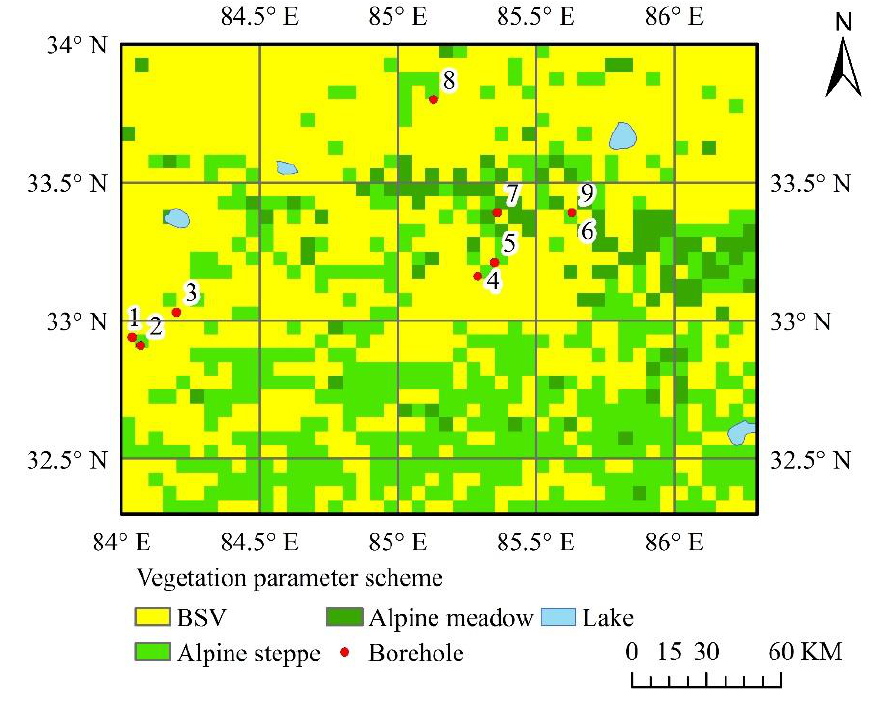
Figure 5. Distribution of vegetation parameter schemes in the Gaize area (Borehole number 1 to 9 correspond to the borehole ID in Table 1).